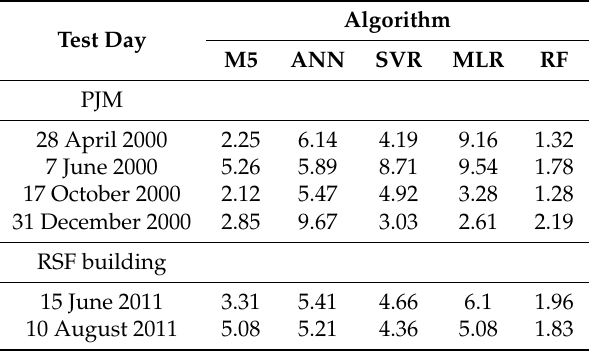
Table 2. Comparison between the different methods for the prediction error of mean absolute percentage error (MAPE) (%) Algorithm Test Day M5